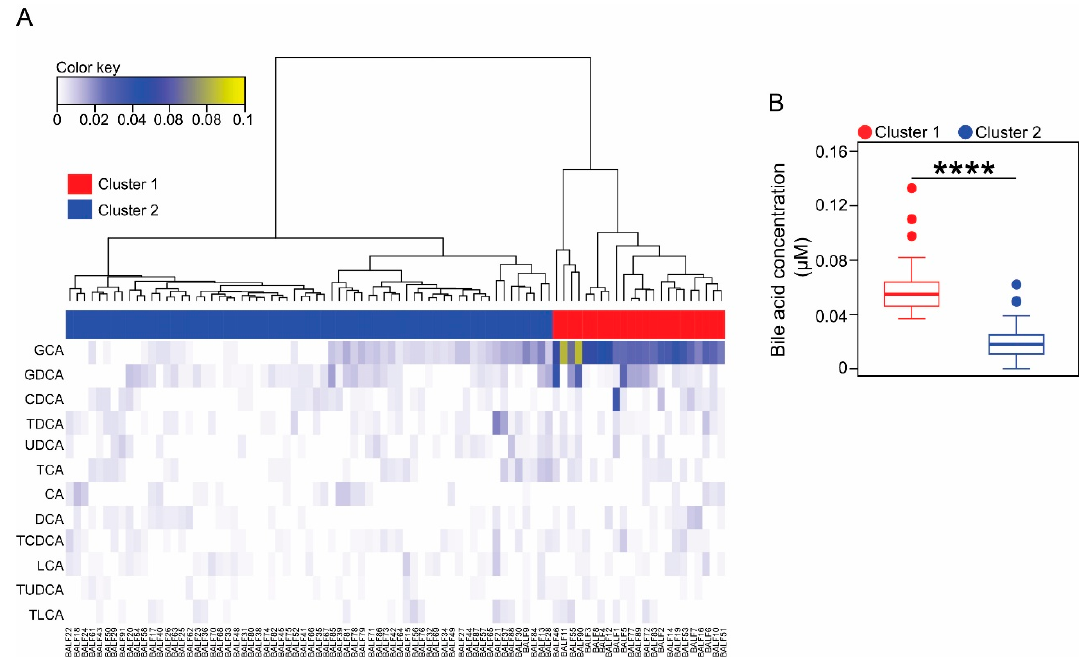
Figure 1. Cluster analysis of BALF samples based on their corresponding bile acids profiles. ( A ) Heatmap showing the bile acid profiles for each BALF sample included in this study. Columns represent individual samples and rows the di ff erent bile acid species profiled. An agglomerative hierarchical clustering approach was applied for grouping the samples based on Ward’s minimum variance method [28,29]. Colour key represents the concentration of each bile acid profiled in micromolar ( µ M) scale. The side colour bar indicates whether the sample was included in cluster 1 (red) or in cluster 2 (blue), after internal validation of the optimum number of clusters. ( B ) Boxplots show the total bile acid concentration for cluster 1 and cluster 2. Asterisks indicate statistical significance for the di ff erences observed between clusters in the context of Mann-Whitney test. **** p -value < 0.0001.